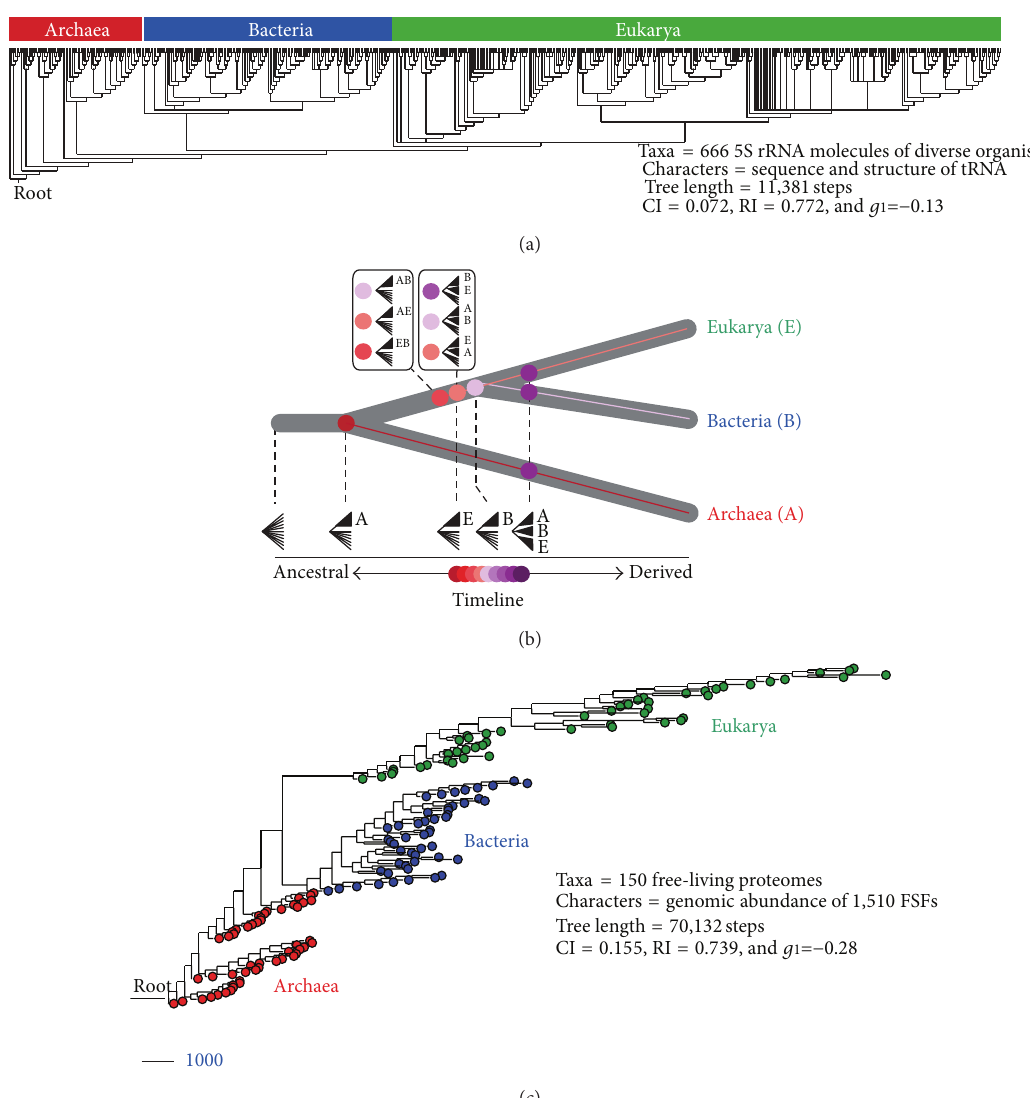
Figure 4: Trees of life generated from the structure of RNA and protein molecules congruently show a rooting in Archaea. (a) A rooted phylogenetic tree of 5S rRNA reconstructed from both the sequence and the structure of the molecules (from [105]). (b) Global most- parsimonious scenario of organismal diversification based on tRNA (from [107]). A total of 571 tRNA molecules with sequence, base modification, and structural information were used to build a ToL, which failed to show monophyletic groupings. Ancestries of lineages were then inferred by constraining sets of tRNAs into monophyletic groups representing competing (shown in boxes) or noncompeting phylogenetic hypotheses and measuring tree suboptimality and lineage coalescence (illustrated with color hues in circles). (c) A ToL reconstructed from the genomic abundance counts of 1,510 FSFs as phylogenetic characters in the proteomes of 150 free-living organisms sampled equally and randomly from the three domains of life (data taken from [122, 123]). Taxa were labeled with circles colored according to superkingdom. CI = consistency index, RI = retention index, and 𝑔 1 = gamma distribution parameter.